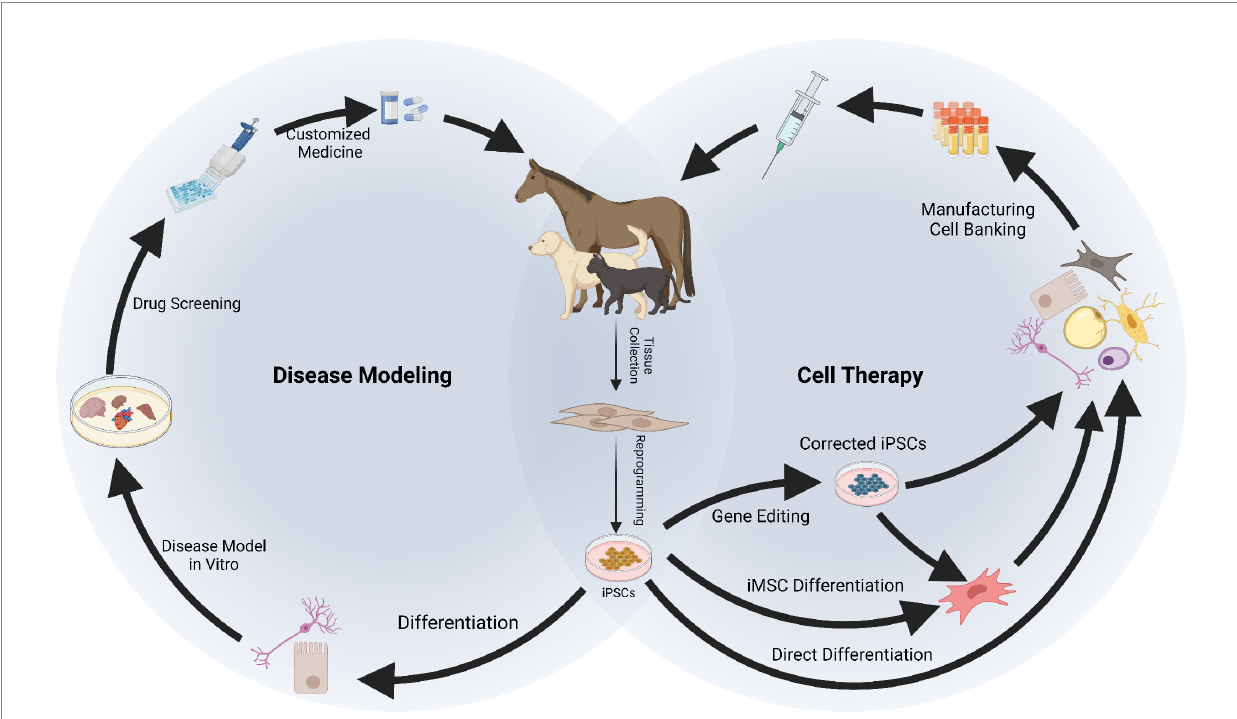
FIGURE 2 Applications of induced pluripotent stem cells (iPSCs) in companion animals for disease modeling and therapy. After reprogramming, iPSCs can be differentiated into specialized cells to recreate a “disease in a dish.” In vitro disease modeling can be used to better understand mechanisms of disease, physiology of the cells and to conduct drug screening, resulting in a more customized approach for therapy. Therapeutic application of iPSCs requires their differentiation into specialized cells or into intermediate progenitors like mesenchymal stromal cells (iMSCs). Gene editing can be used at this stage to obtain healthy cells from patients carrying genetic disorders. The iPSCs, iMSCs, and/or their derivatives can be manufactured and banked for therapeutic use. Created with